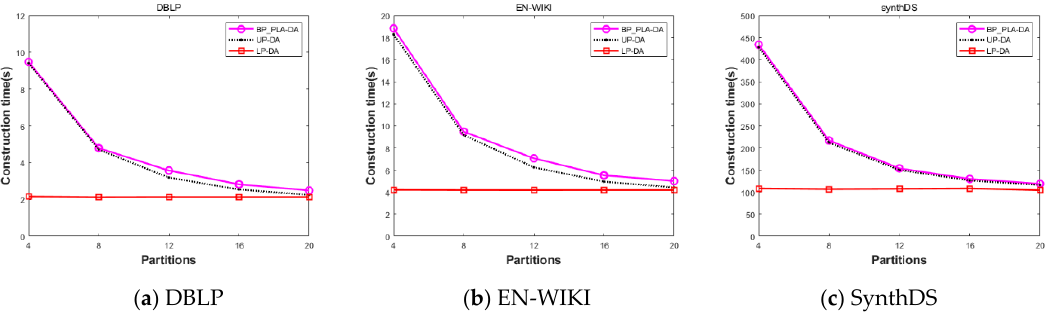
Figure 8. Construction times for different partition numbers.